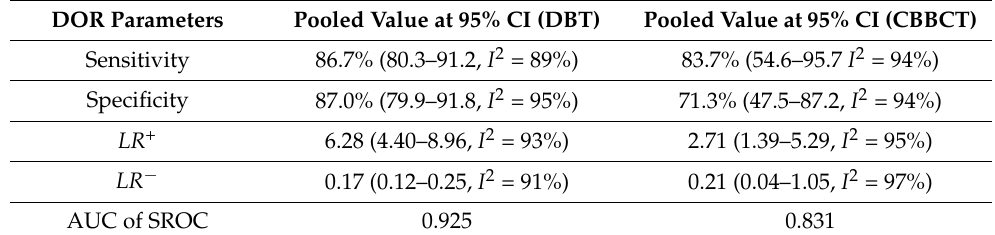
Table 2. Summary of all estimated diagnostic test accuracy. DOR